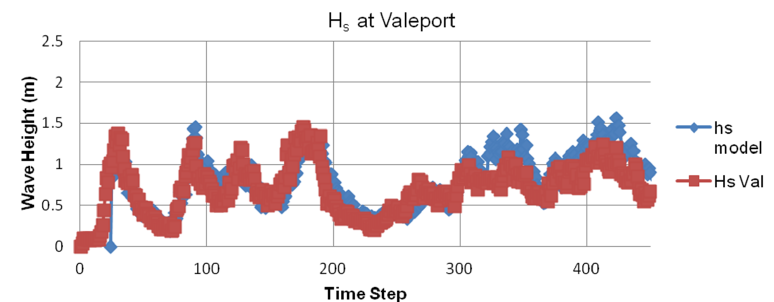
Figure 7. Modelled vs. recorded Hs in Dingle Bay.